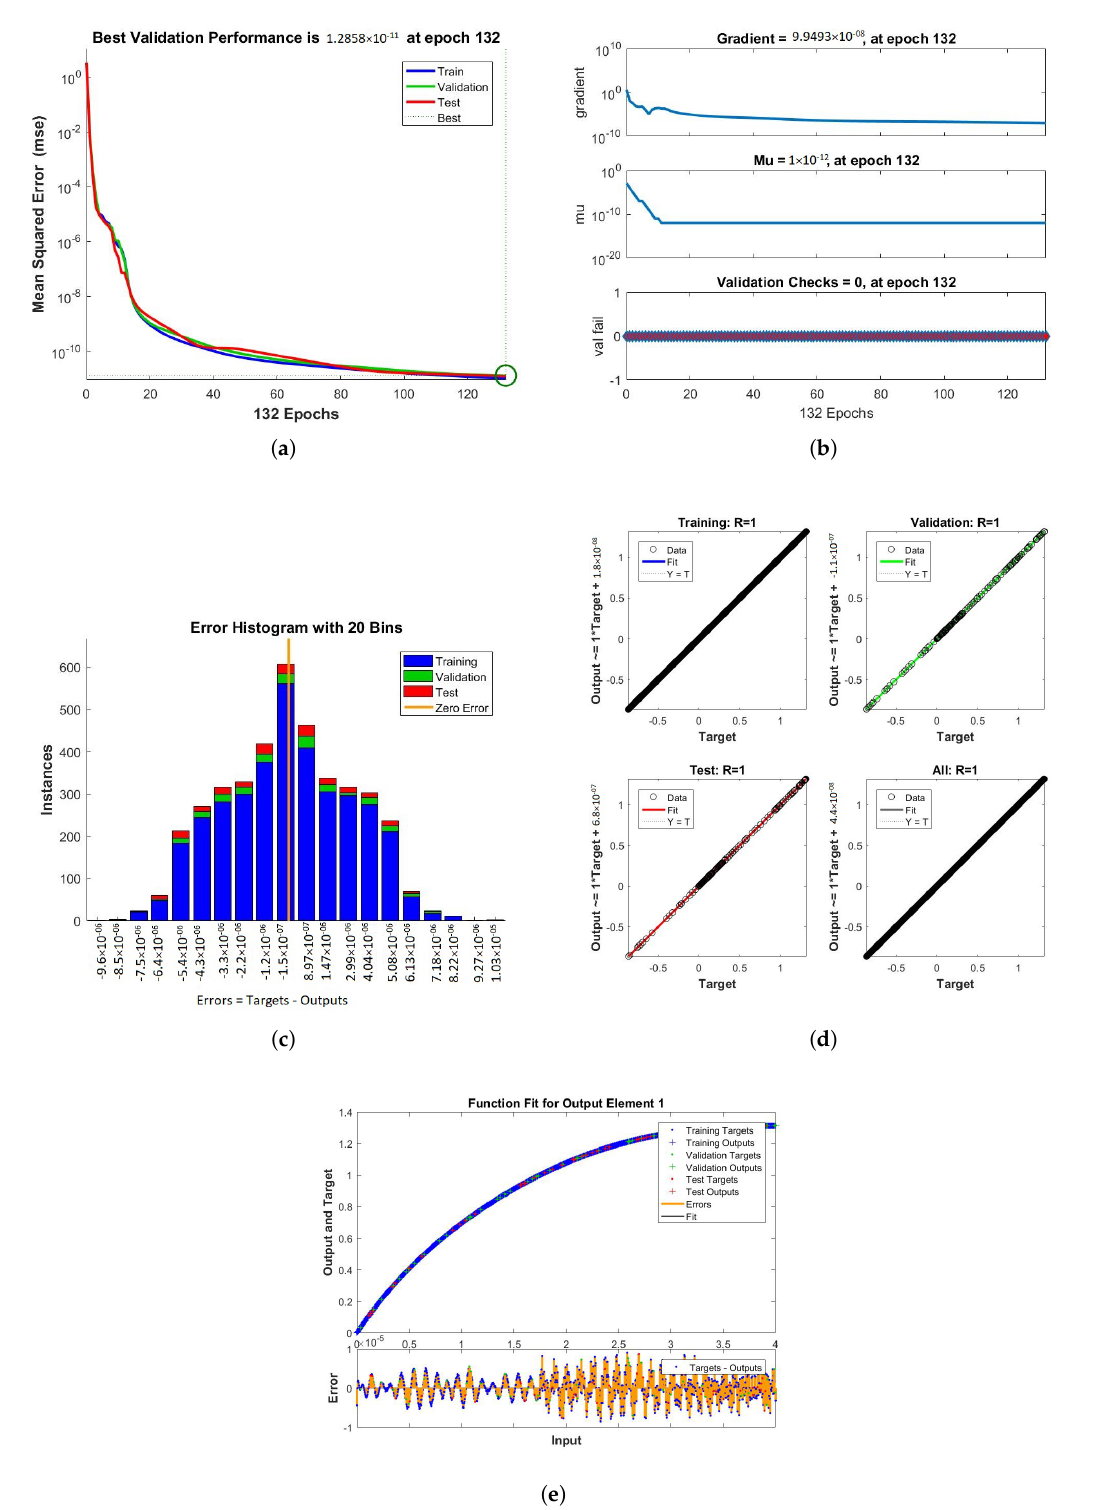
Figure 10. Figures of performance, training, error histogram, regression, and fitness of our system were obtained from LMBNN while using the value of rotation parameter K = 0.2. ( a ) Performance. ( b ) Training. ( c ) Error Histogram. ( d ) Regression. ( e )